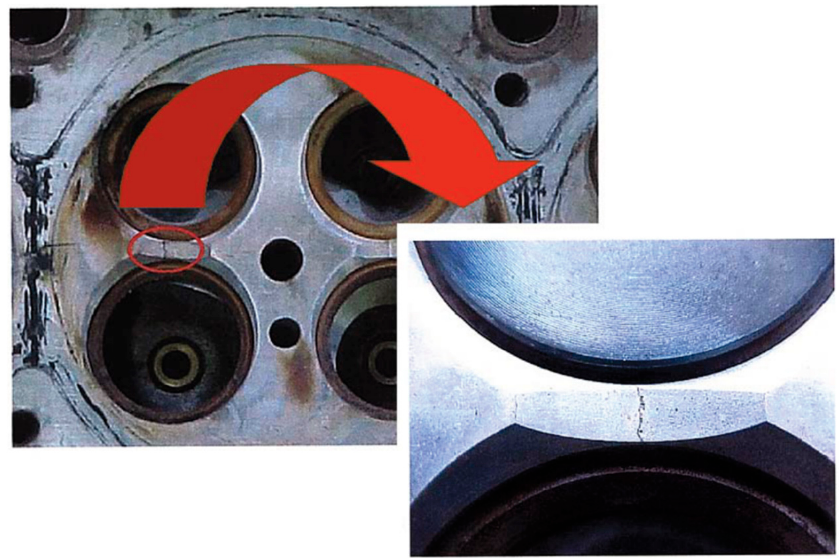
Figure 1. Initiation of crack on the bridge between the valve seats for an automotive cylinder head (©Montupet). head